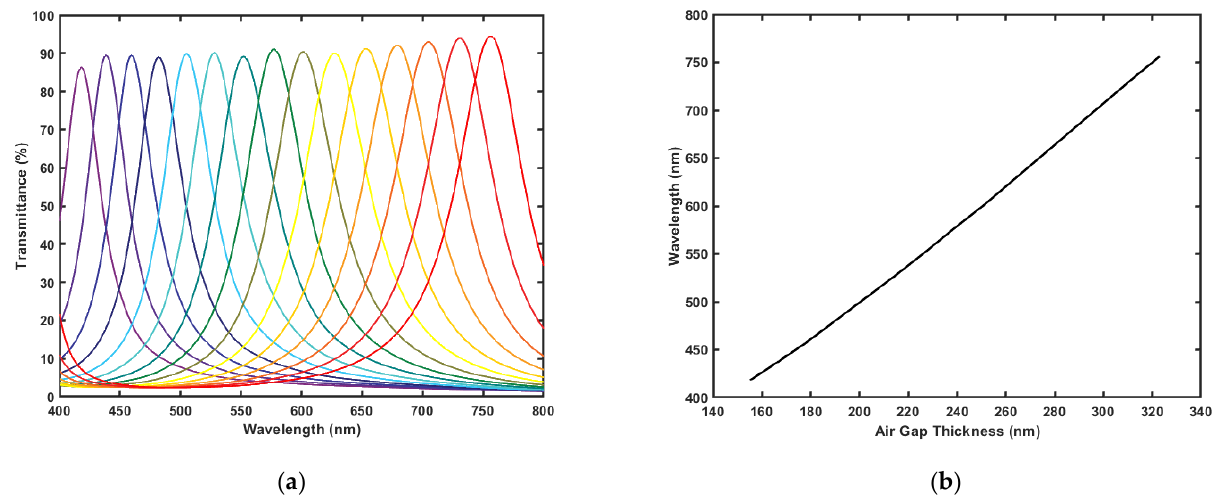
Figure 4. Results generated by MATLAB code for the design optimized for maximum transmission: ( a ) Transmission spectra of the filter at different air gap values; ( b ) Resonance wavelength versus the tuned air gap thickness of the filter.